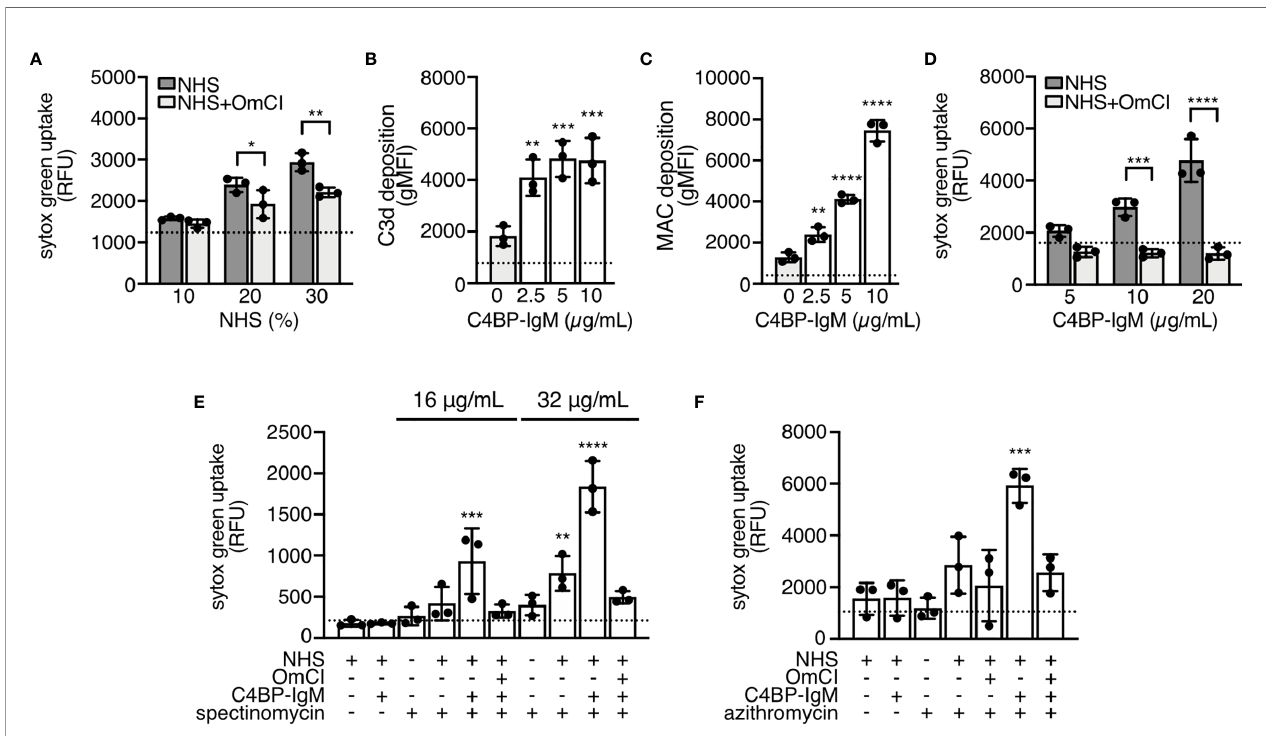
FIGURE 3 | NHS and C4BP-IgM induce membrane damage of N. gonorrhoeae FA1090 through MAC formation. (A, D) FA1090 gonococci were incubated for 3 hours with increasing concentration of NHS (10%, 20%, 30%) (A) or with 10% NHS and increasing concentrations of C4BP-IgM (5, 10 and 20 m g/mL) (D) . Internalization of sytox green was measured after 30 min incubation. Differences among samples were compared using two-way ANOVA with Sidak´s multiple comparison test. Dotted line indicates fl uorescent value in the absence of NHS or C4BP-IgM, respectively. (B, C) FA1090 gonococci were incubated with 10% NHS and 2.5, 5 or 10 m g/mL of C4BP-IgM. Deposition of C3d and MAC was measured by fl ow cytometry. Dotted line indicates value in the presence of HINHS. One-way ANOVA with Dunnett´s multiple comparison test was performed considering NHS as reference. (E, F) FA1090 gonococci were incubated for 3 hours in the presence or in the absence of 10% NHS+/-5 m g/mL C4BP-IgM and 16 or 32 m g/mL of spectinomycin or 125 ng/mL of azithromycin. Internalization of sytox green was measured after 30 min incubation. One-way ANOVA with Dunnett´s multiple comparison test was performed considering NHS as reference. Dotted line indicates fl uorescent value in the presence of bacteria alone. In all graphs n = 3. *p < 0.05, **p < 0.01, ***p < 0.005, ****p <